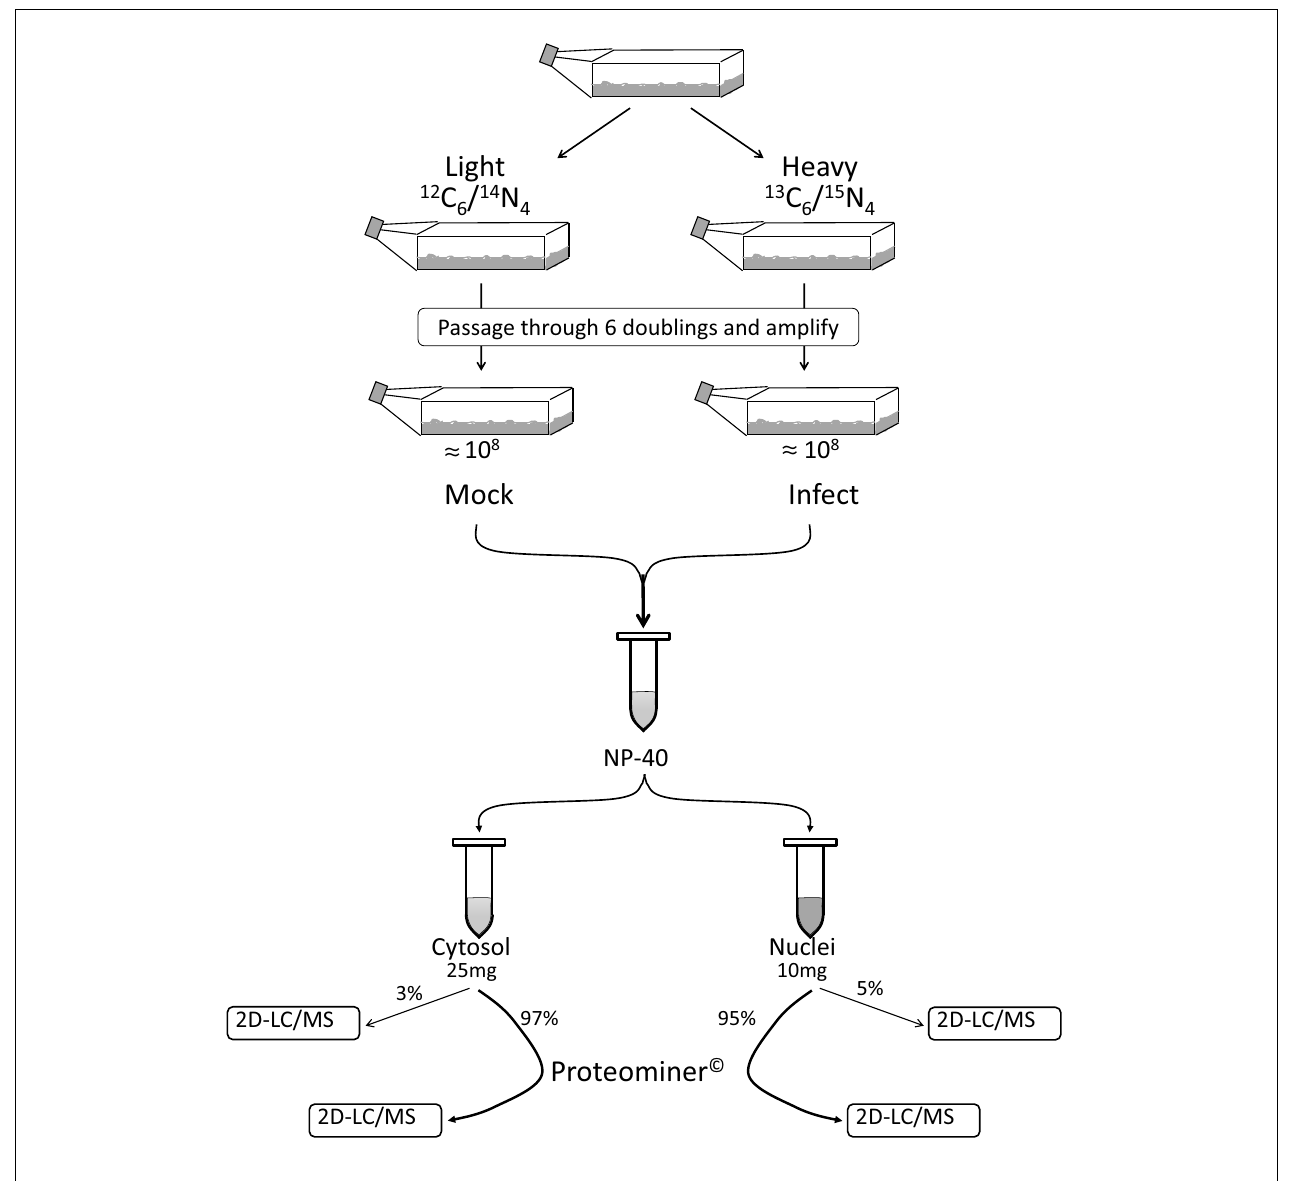
nucleus, 95–95% of each fraction was non-specifically enriched for low-abundance proteins by reaction with Proteominer ™ (PM) beads. Each of the four fractions (two PM-enriched as well as two residual 3–5% “standard” fractions) were then processed by